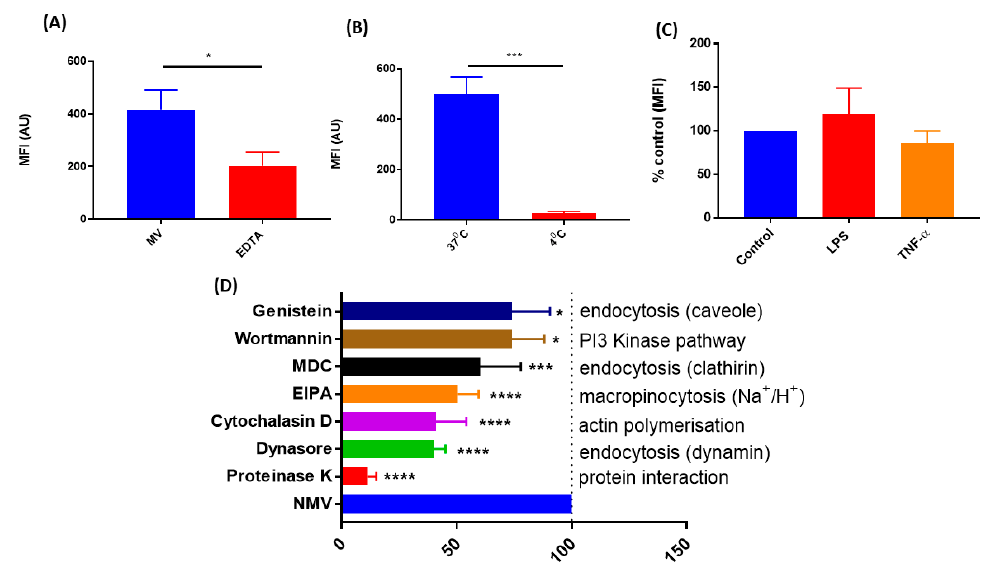
Figure 3. Mechanisms of NMV internalization by hCMEC/D3 cells. ( A ) Co-incubation with EDTA, a metal ion chelator significantly reduced internalization. ( B ) NMV internalization was significantly reduced at 4 °C. ( C ) Pre-incubation with LPS (1 µg/mL) and TNF- α (10 ng/mL) did not affect internalization. ( D ) hCMEC/D3 cells were pre-incubated with pharmacological inhibitors genistein, wortmannin, MDC, EIPA, cytochalasin D, Dynasore, and also proteinase K and PKH-67 labeled NMV were added for 2 h. Data represent 3–5 independent experiments and are presented as the percentage of NMV uptake compared to the positive control with no inhibitors (mean ± SD, One-way ANOVA with Dunnett’s multiple comparison test * p < 0.05, *** p < 0.001, **** p < 0.0001).